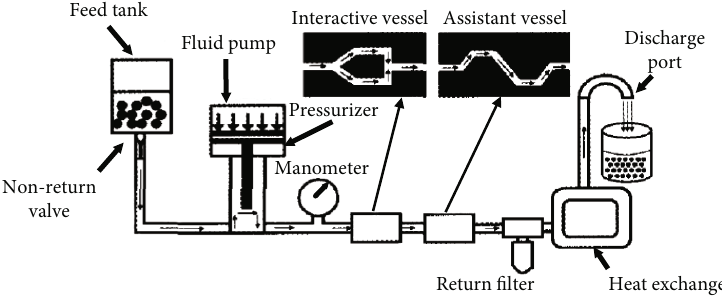
Figure 1: Technological process of the micro fl uidization